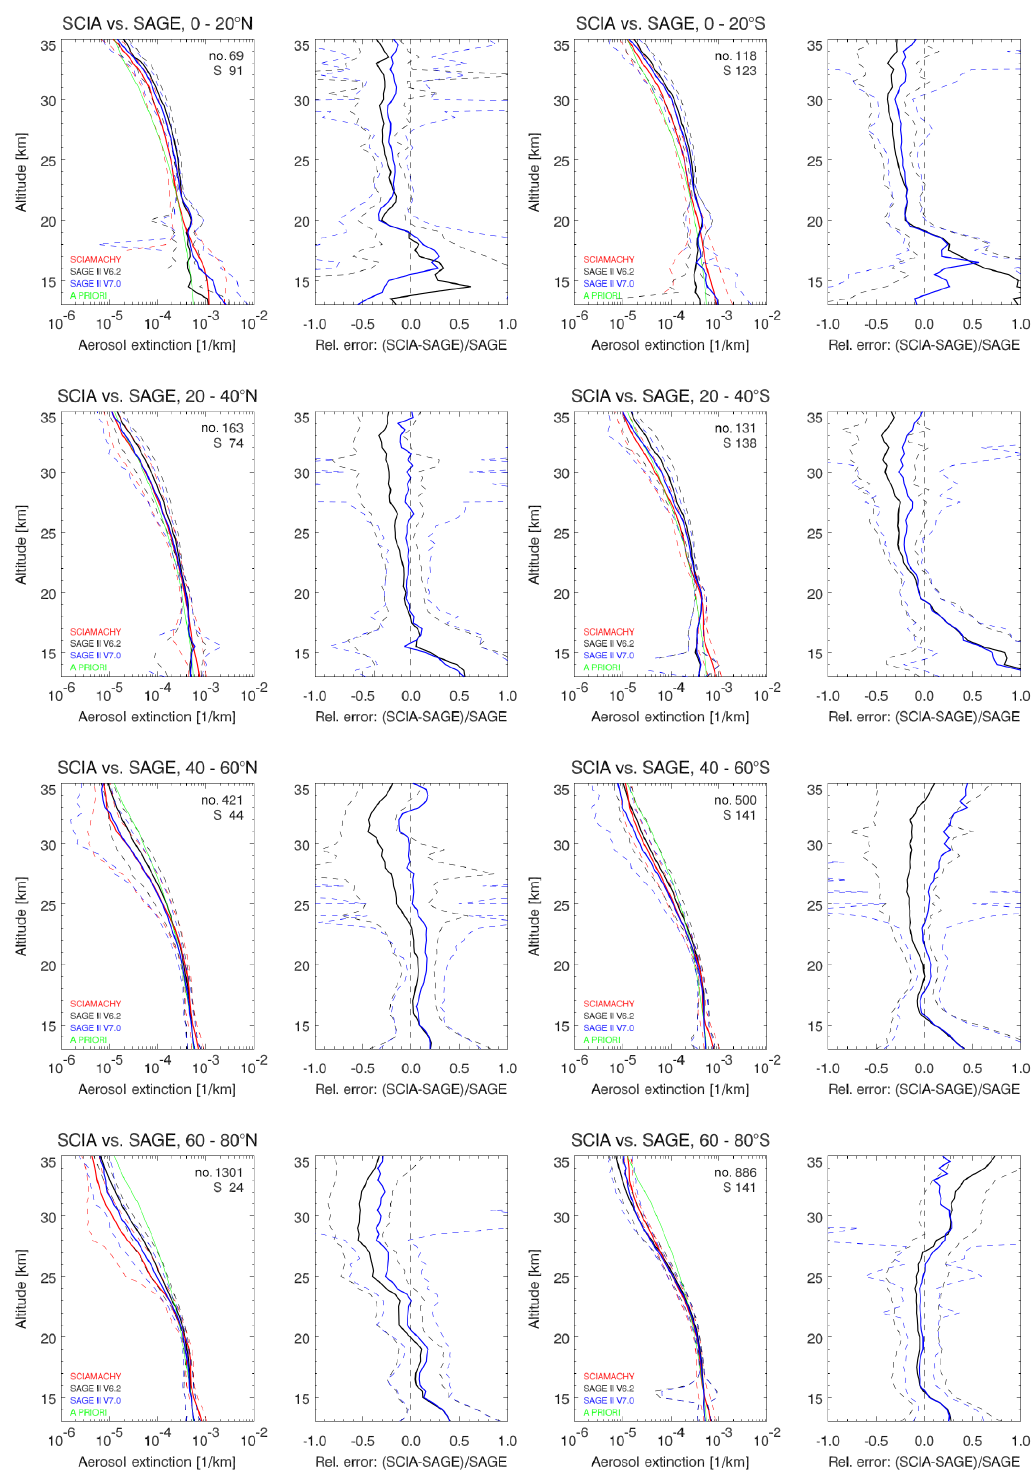
Figure 3. Left panels: comparison of the retrieved SCIAMACHY 525nm aerosol extinction profiles (red solid line) with SAGE II version 6.2 (black solid line) and version 7.0 (blue solid line) aerosol extinction for eight latitude bins. The dashed lines show the corresponding standard deviations. The green line again shows the SCIAMACHY a priori profile. The numbers in the top right corner show the number of co- locations averaged (“#”) and the average scattering angle (“ S ”) in degrees. Right panels: mean relative difference between SCIAMACHY and both versions of SAGE II aerosol extinction profiles (solid lines with the same color code as in the left panels) with standard deviations